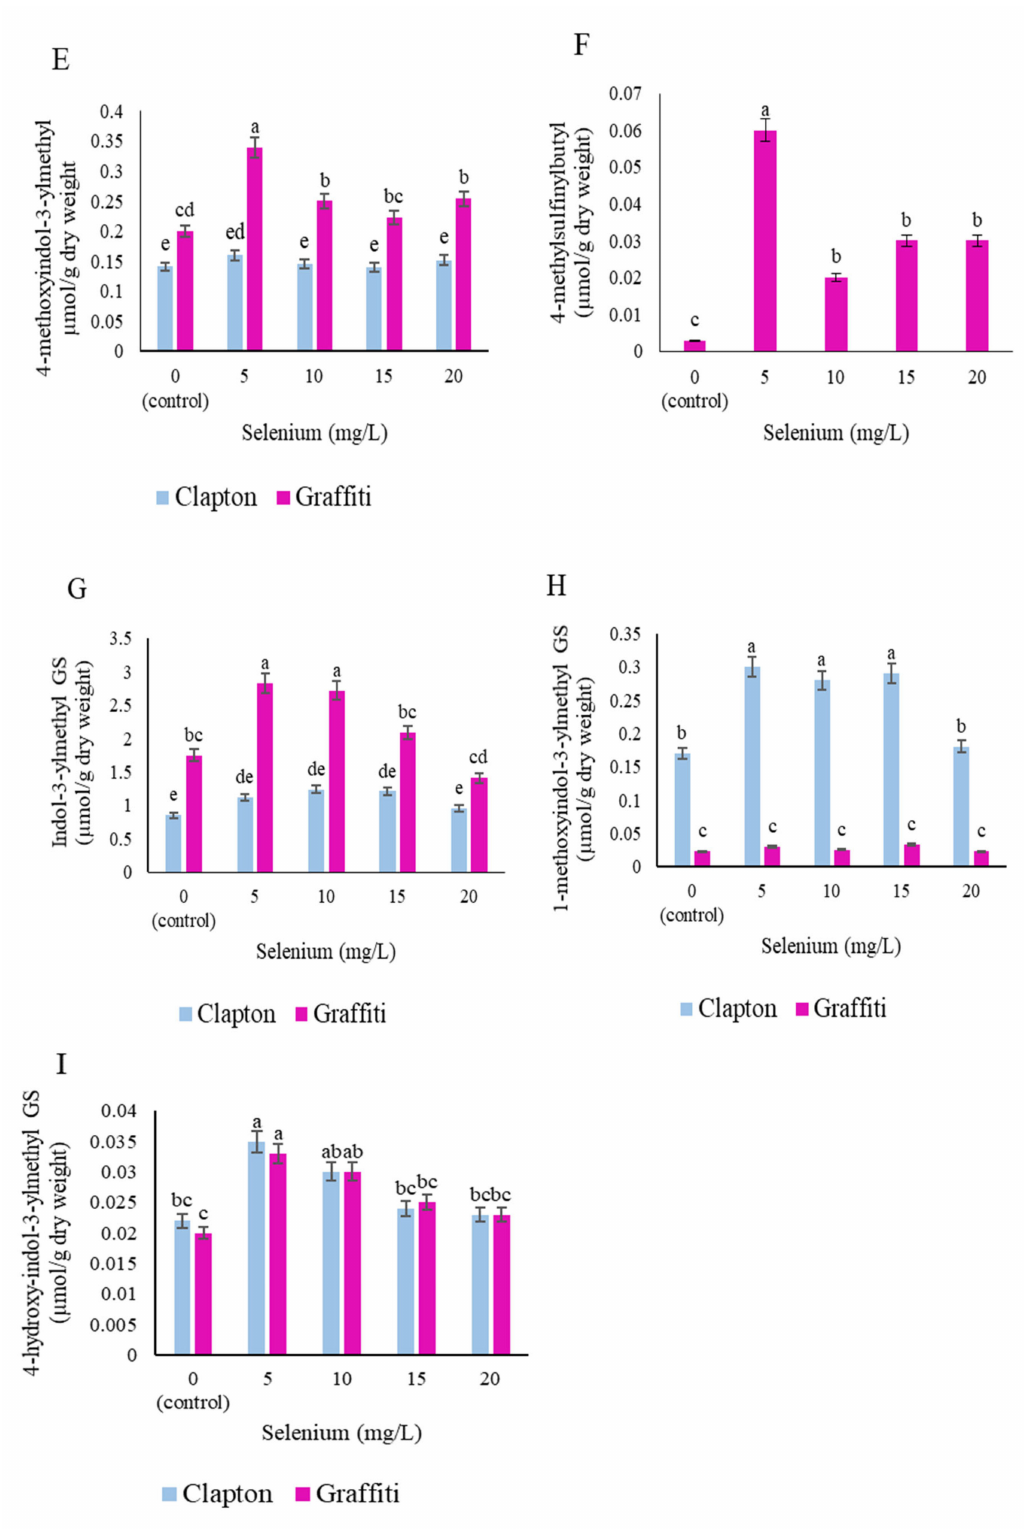
Figure 2. Mean comparison of sodium selenate treatments on glucosinolate (GS) of cauliflower leaves (“Clapton, “Graffiti”). ( A ) Total GS, ( B ) Aliphatic glucosinolates, ( C ) Indolic glucosinolates, ( D ) 3-methylsulfinyl-propyl GS, ( E ) 4-methoxyindol-3- ylmethyl GS, ( F ) 4-methylsulfinylbutyl GS, ( G ) indol-3-ylmethyl GS, ( H ) 1-methoxyindol-3-ylmethyl GS and ( I ) 4-hydroxy- indol-3-ylmethyl GS. Shown are the mean ± standard deviations of three replicates. Bars marked by the same letter are not significantly different ( p ≤ 0.05, Duncan’s multiple range